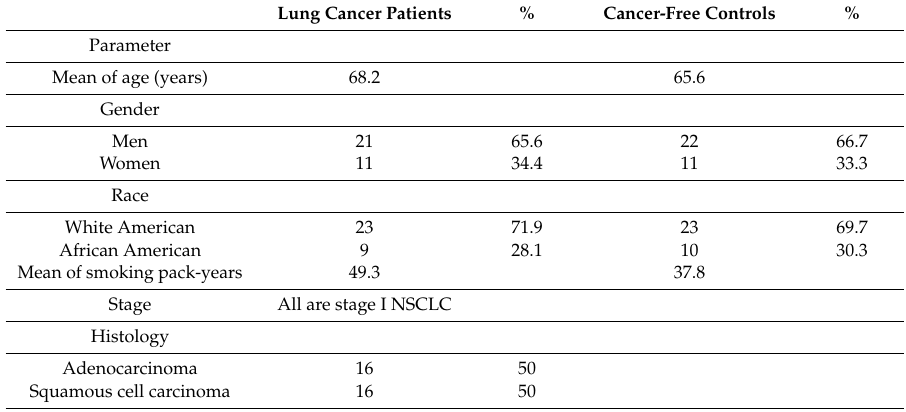
Table 1. Demographic and clinical data of 32 lung cancer patients and 33 cancer-free smokers.